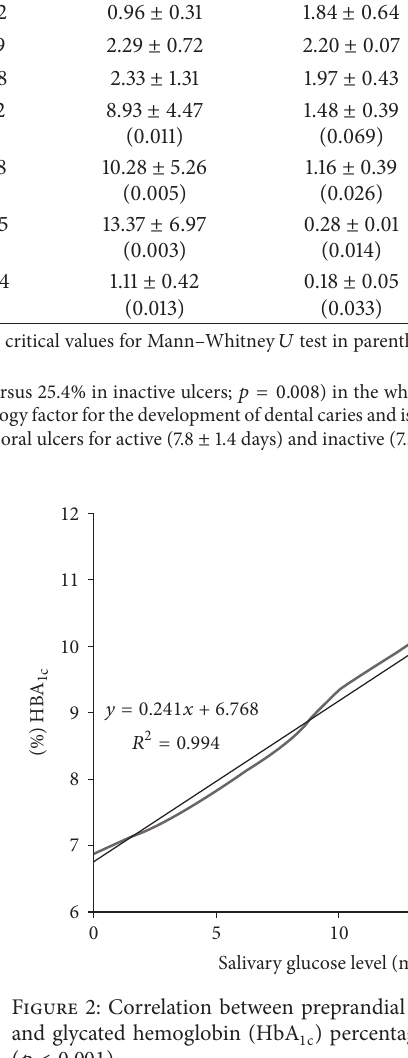
Figure 1: Correlation between preprandial salivary and serum glucose levels in DM study group ( 𝑝 < 0.001 ).